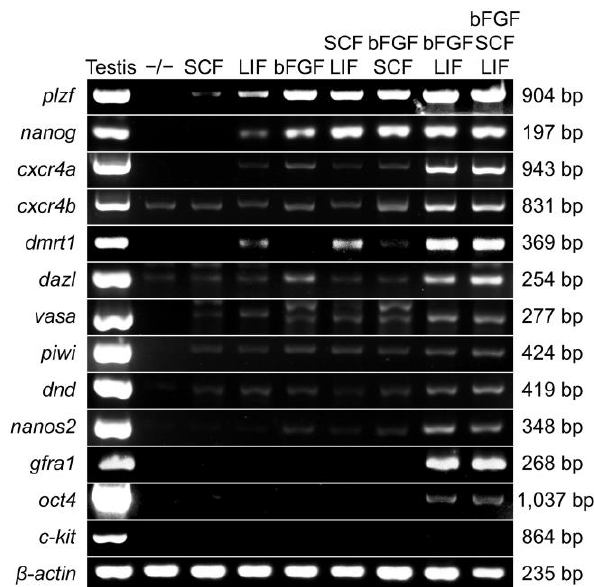
Figure 4. Expression analysis of germ cell marker genes in GPT cells treated with different cytokine combinations. The cDNA samples included testis and the GPT cells cultured with different cytokine combinations or without bFGF, LIF, and SCF (-/-). In the -/- combination, the GPT cells almost did not express any of the listed germ cell marker genes, except for cxcr4b and dazl . In the bFGF and LIF combinations supplemented with or without SCF, almost all listed germ cell marker genes could be detected in the GPT cells, except for c-kit . In the remaining combinations, the GPT cells expressed only some of the listed germ cell marker genes. The β -actin was used as an internal